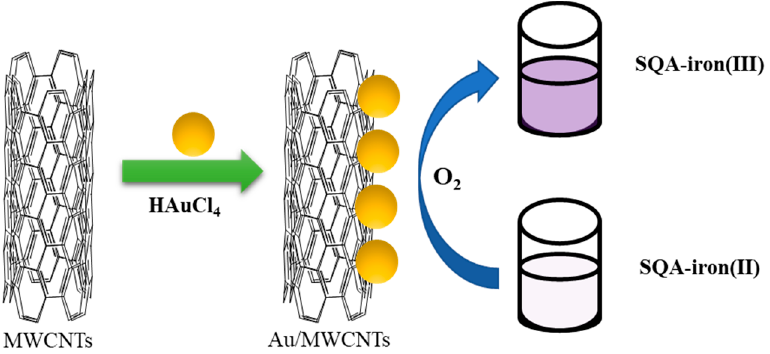
Scheme 1. The catalytic activity of Au/MWCNTs composites under the SQA-iron(II/III)